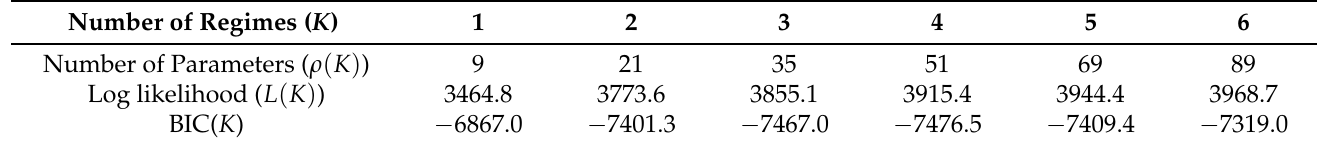
Table 2. Determination of the optimal number of